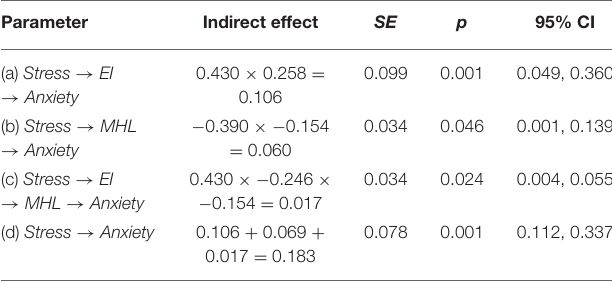
TABLE 2 | Standardized indirect effects of stress of COVID-19 on anxiety.